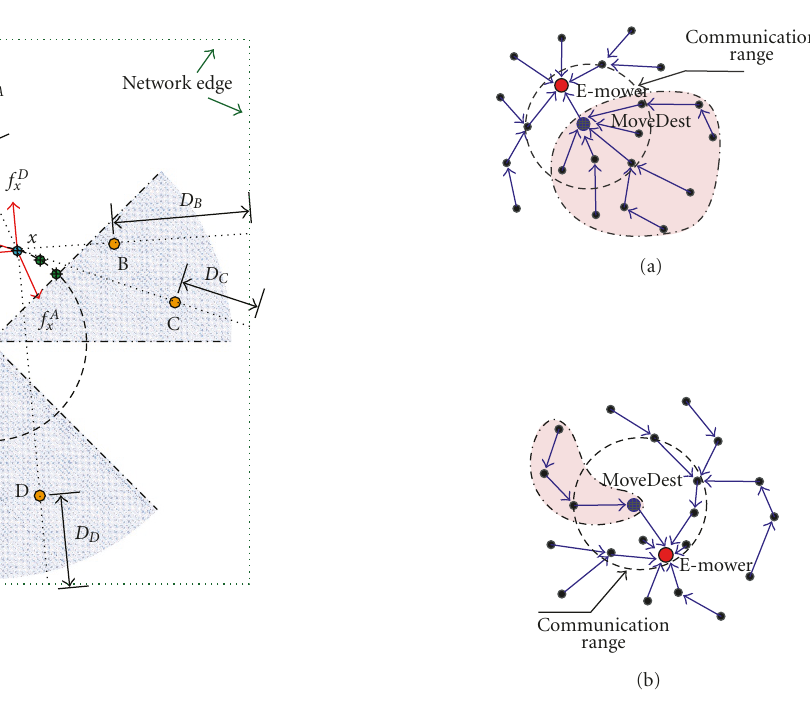
Figure 3: Di ff erent sojourn positions of the energy mower cause di ff erent forwarding workloads of